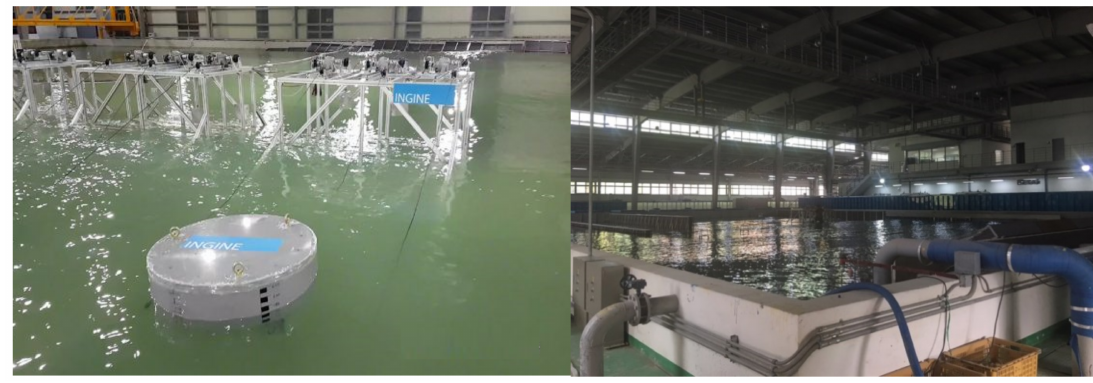
Figure 6. Scene from the wave tank experimental site.